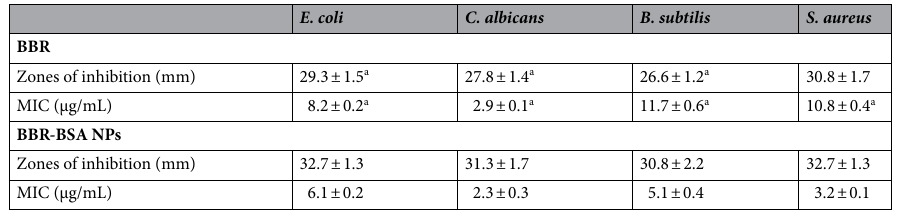
Table 2. Antimicrobial activities of BBR and BBR-BSA NPs. Zones of inhibition (mm) were observed at a concentration of 1.8 mg BBR/mL. Minimum inhibitory concentrations (MICs) were introduced at μg/mL. Data values are expressed as means ± SD (n = 5). a Represent a significant difference at P < 0.05 compared to BBR-BSA NPs as determined by the one-way ANOVA with post hoc LSD